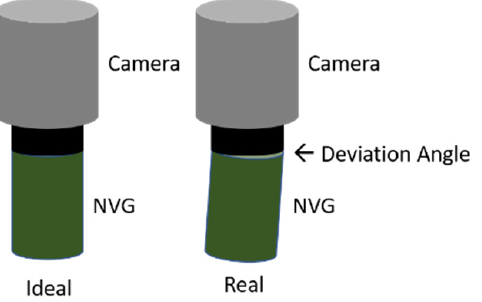
Figure 3. Situation of a minor error between lens and night vision goggles (NVG).